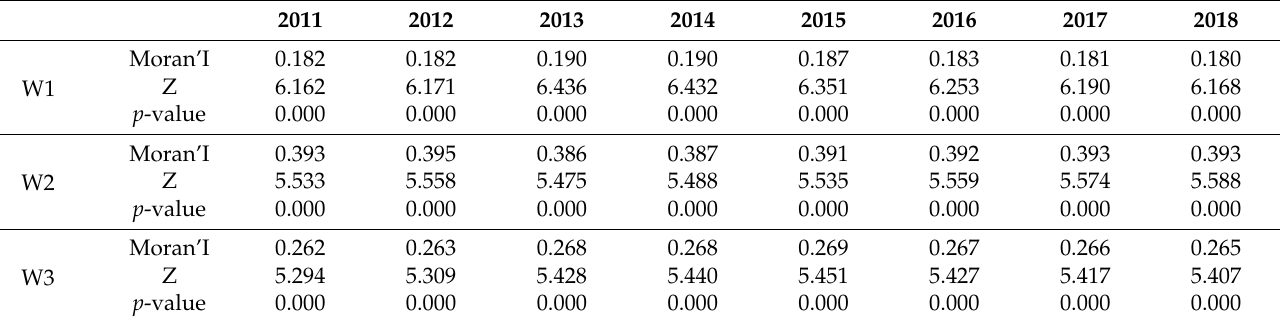
Table 5. Moran’I index for disposable